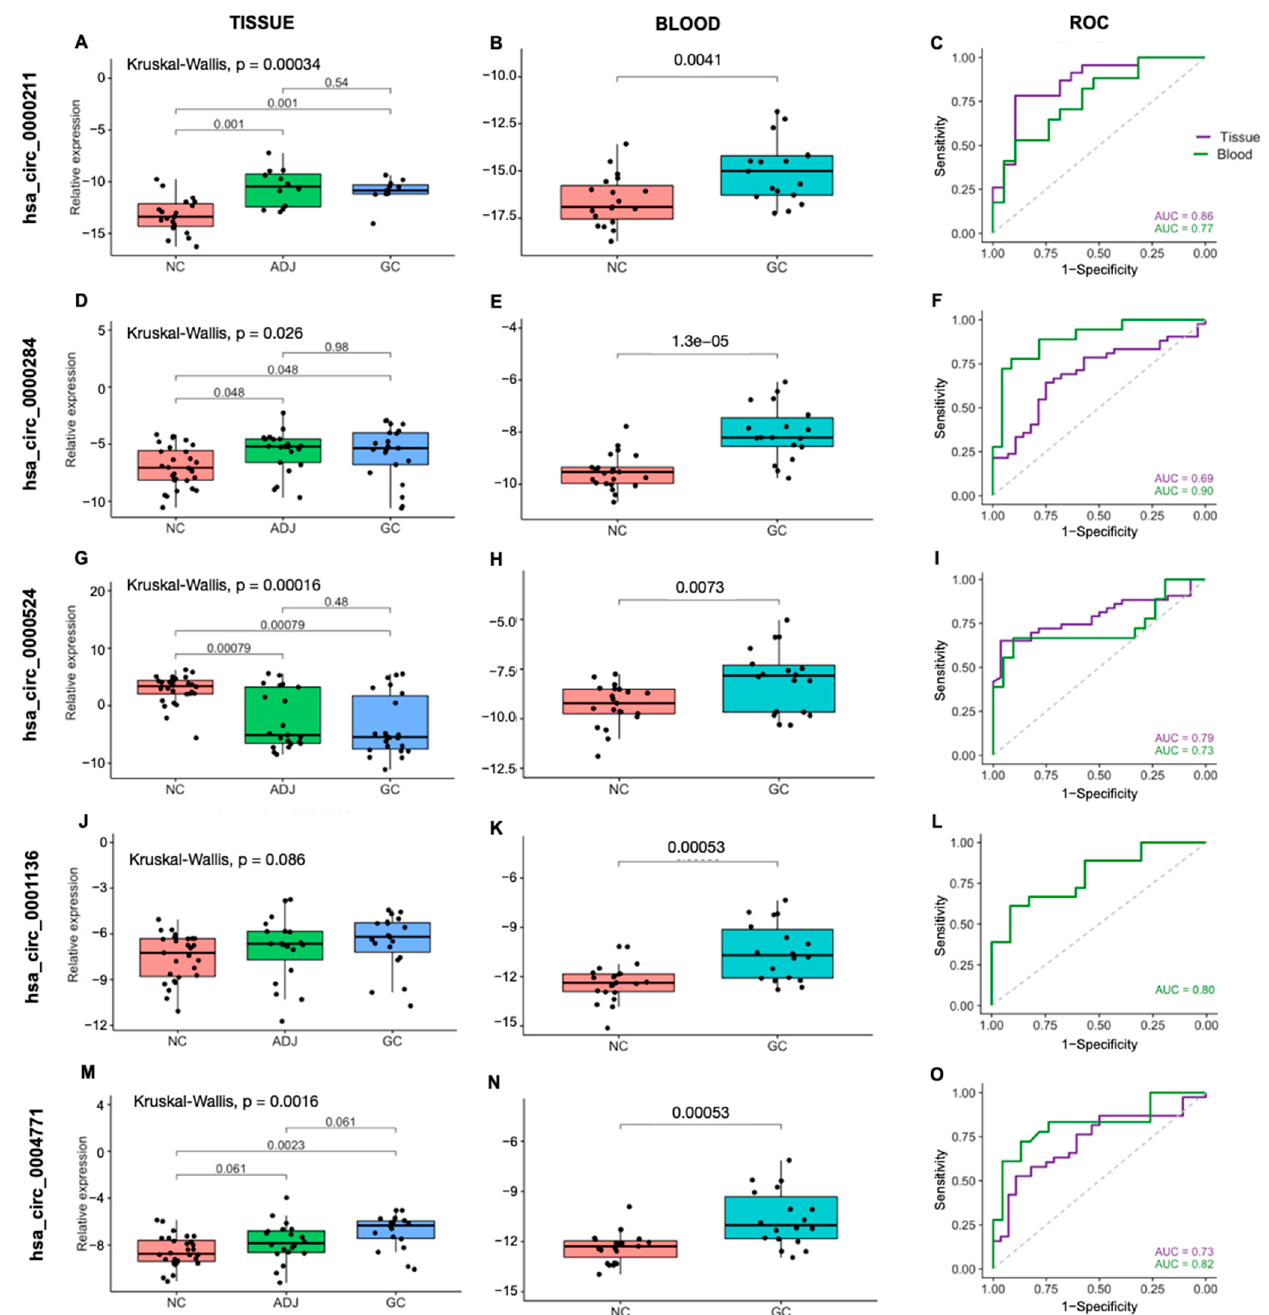
Figure 1. Expression profile and ROC curves for the five circRNAs in gastric tissues and blood samples. ( A – C ) hsa_circ_0000211, ( D – F ) hsa_circ_0000284, ( G – I ) hsa_circ_0000524, ( J – L